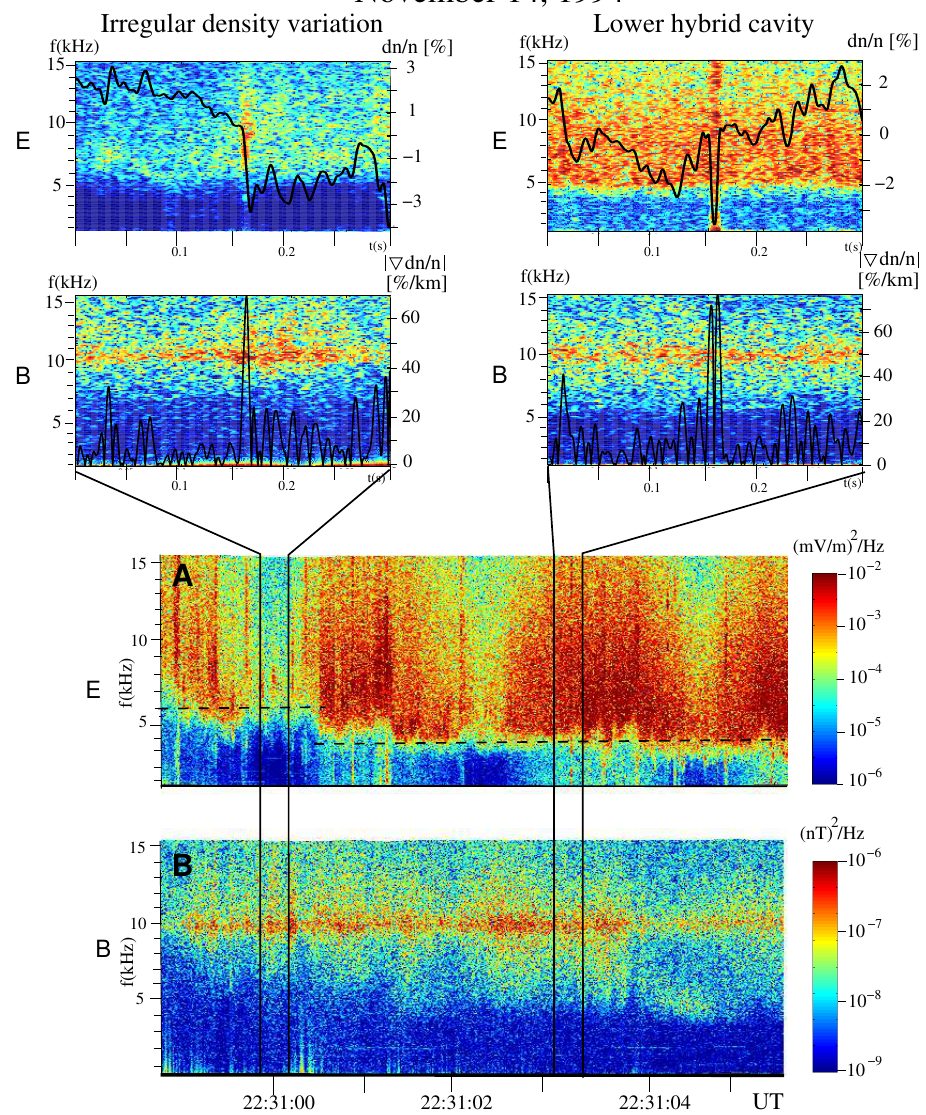
Fig. 2. The two large panels show 7-s long electric and magnetic field spectrograms from 14 November 1994. At 22:31:00.5 UT the total density changes from 7900cm − 3 to 3100cm − 3 . The associated change in the lower hybrid cutoff frequency is marked with dashed lines in panel (A) . Before the density drop irregular density variations are found and after are LHCs detected. Enlarged are 0.3s from two parts of the burst. The two top-left panels show an irregular density variation event and the two top-right panels show an LHC event.